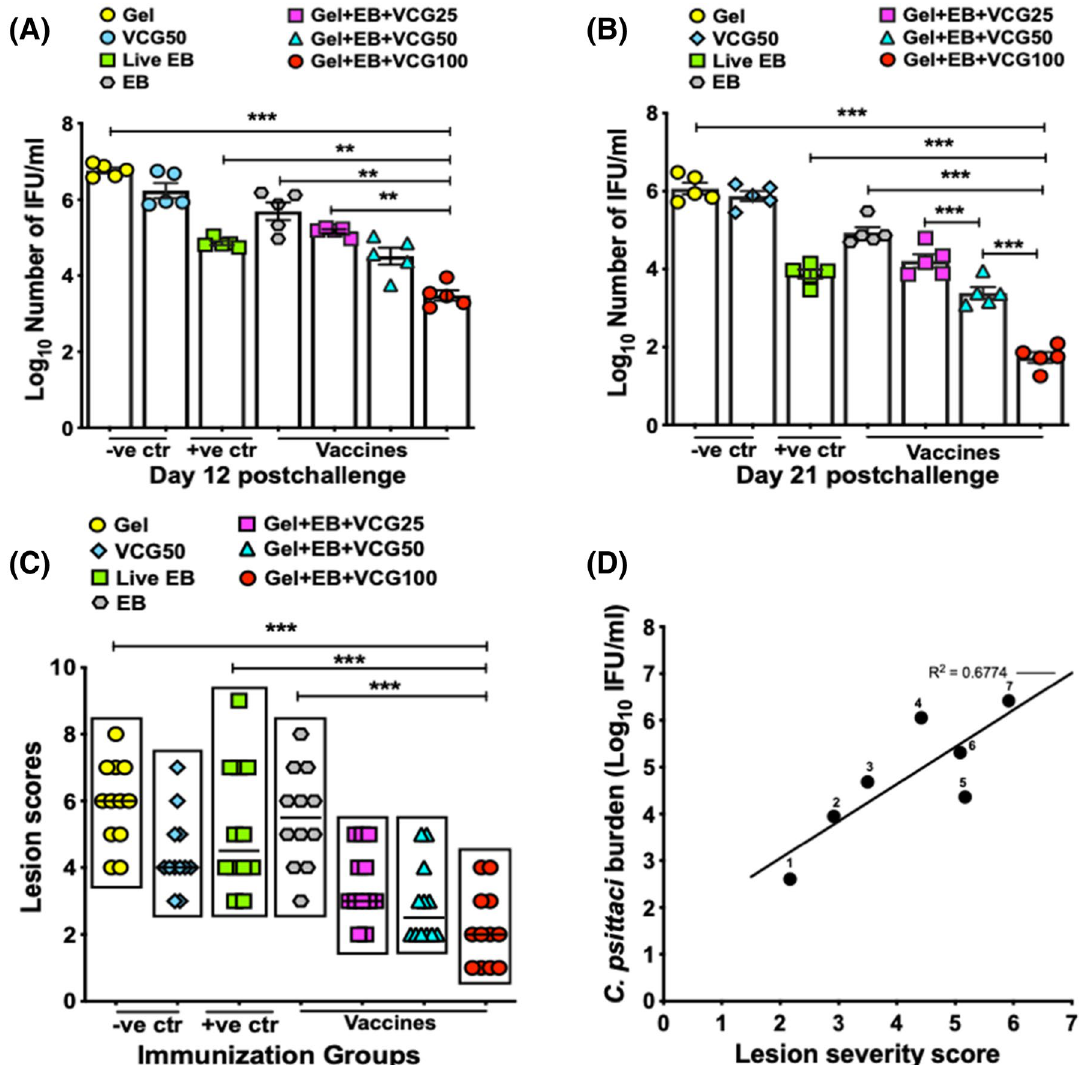
Figure 9. Evaluation of pharyngeal C. psittaci burden and pathological lesions in chickens immunized with UV-inactivated EB in combination with different doses of VCG, and relationship of pharyngeal C. psittaci burden to lesion severity. Groups of chickens were immunized and boosted IN as described in the materials and methods section. Immunized and control chickens were challenged 3 weeks after the booster immunization. Pharyngeal swabs were obtained from individual chickens (6/time point) on days 12 ( A ) and 21 ( B ) post challenge and C. psittaci was isolated from pharyngeal swabs in tissue culture. Chlamydial inclusions were detected by immunofluorescence using the Imagen immunofluorescence kit (Oxoid, Cambridge UK) and enumerated. The data is shown as the number of recoverable IFUs expressed as log 10 IFU/ml per group. ( C ) Lungs and air sacs were harvested from immunized chickens (12/group) 3 weeks after challenge and gross pathological lesions were evaluated and scored. The total lesion severity scores were then calculated and recorded for each chicken. The data is shown as the calculated total lesion severity scores (the sum of the scores for lungs, thoracic and abdominal air sacs) of individual chickens. Differences between experimental groups were compared by One-way ANOVA with Tukey’s post multiple comparison test at p *** < 0.001 and p ** < 0.01. Abbreviations: − ve ctr negative controls; + ve ctr positive control. ( D ) The mean lesion severity scores and mean number of IFU were calculated and plotted for each vaccine group. Data are combined from days 12 and 21 postchallenge. Pharyngeal C. psittaci burden values are plotted along the Y-axis, and the lungs/air sacs lesion severity scores are plotted along the X-axis. Each dot represents a single immunization group. 1, Gel-EB- VCG100; 2, Gel-EB-VCG50; 3, Gel-EB-VCG25; 4, VCG50; 5, Live EB; 6, EB alone; 7, Gel alone. The correlation between lesion severity and pharyngeal C. psittaci burden was evaluated by Spearman’s correlation coefficient; R 2 = 0.6774. Abbreviations: − ve ctr negative controls; + ve ctr positive